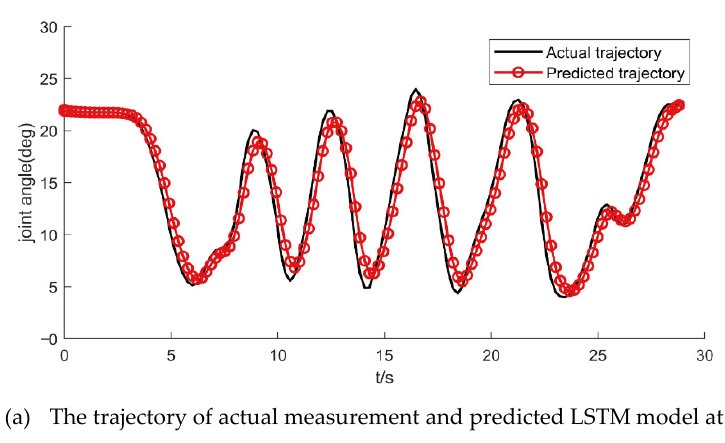
Figure 6. Cooperation movement of the lower limb exoskeleton and human.